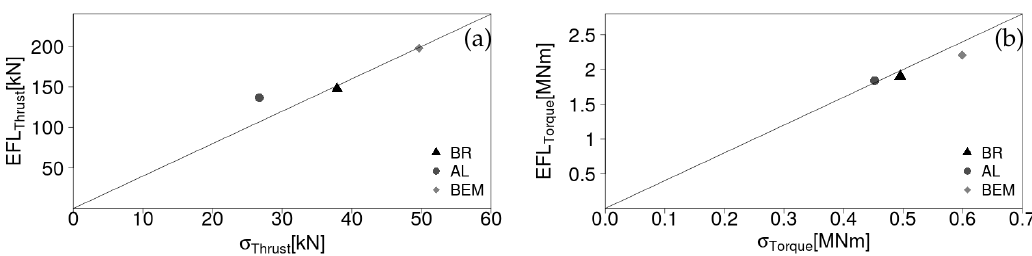
Figure 13. EFL dependence on standard deviation for ( a ) thrust and ( b ) torque for all three methods. The diagonal line is governed by EFL = 4 σ .